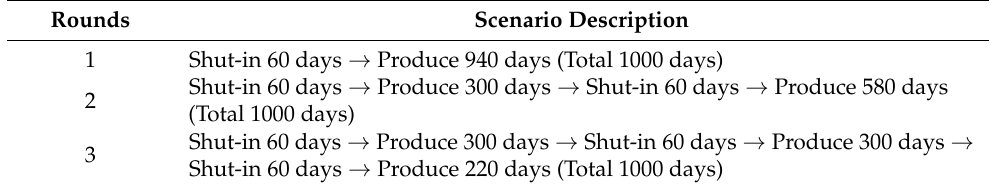
Table 6. Operation design for simulation scenarios with multiple rounds of